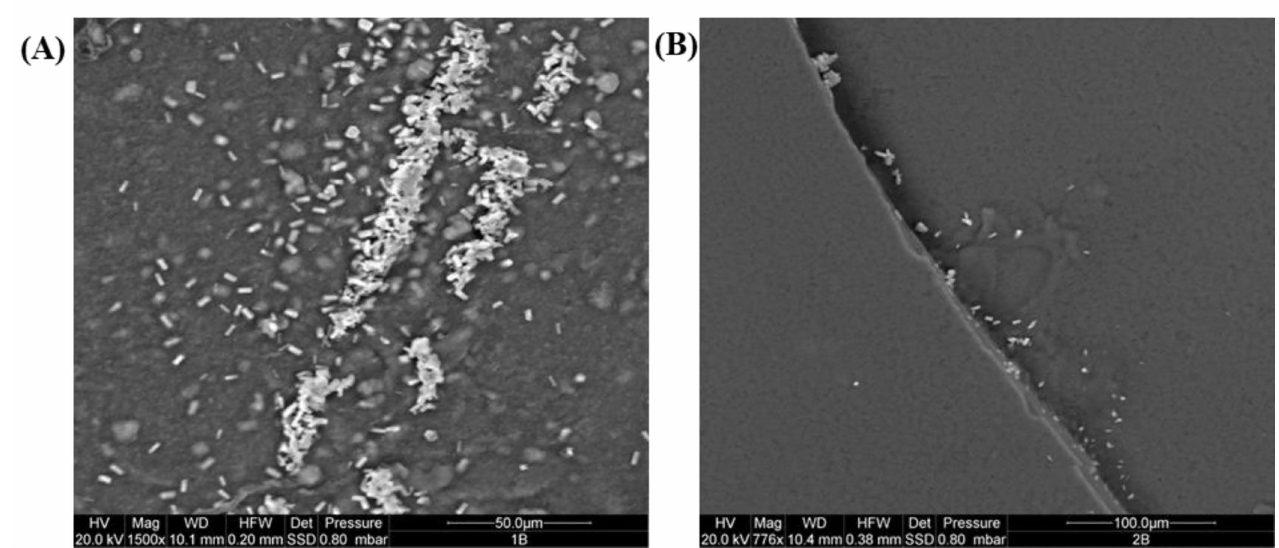
Figure 4. Representative ESEM images of AC 012 ( A ) and AC 013 ( B ) resins with evident bacilli growth on their surface after 7 days of